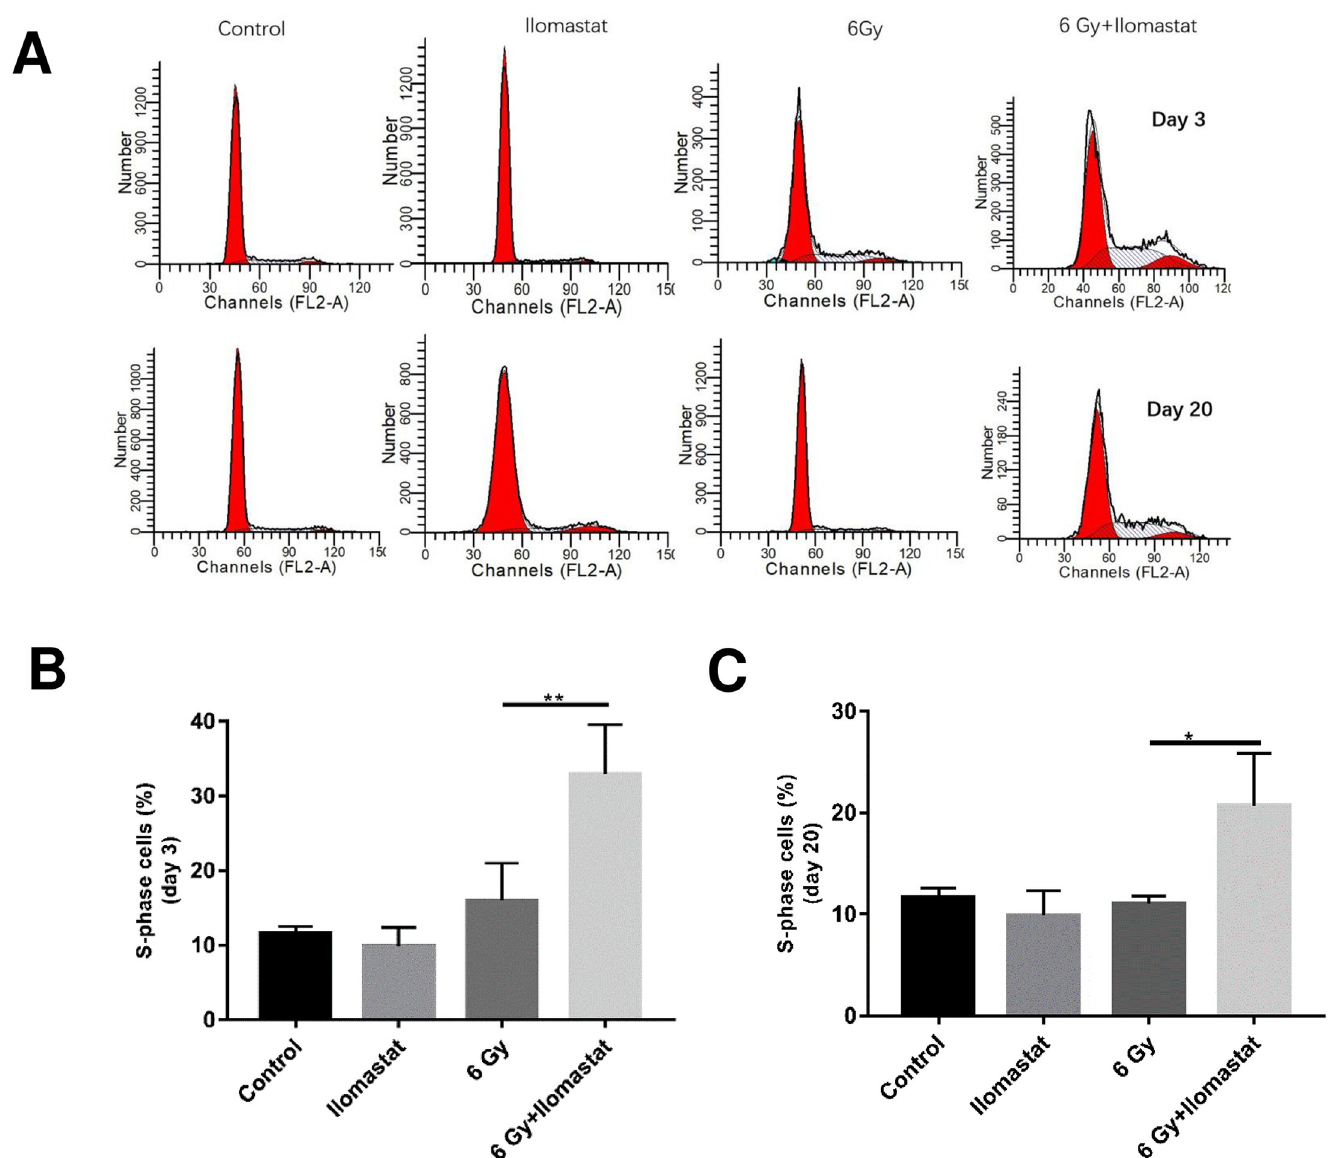
Fig 3. Ilomastat pretreatment stimulates the cell proliferation of BM in irradiated mice. Effect of Ilomastat on radiation mediated compromised proliferative ability in BM was evaluated by analysis of S-phase cells in the BM. Representative DNA flow cytograms (A) . Frequency of S-phase cells in the BM of mice at day 3 (B) and 20 (C) post 6 Gy γ -ray irradiation. More than 10,000 BM cells were analyzed for each experiment and the experiments were repeated for three times independently. � P < 0.05, �� P < 0.01. n = 8 in all groups.